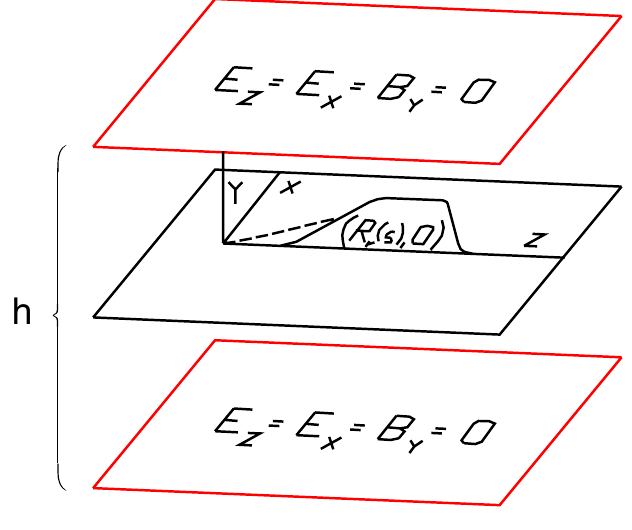
FIG. 1. (Color) Basic lab frame